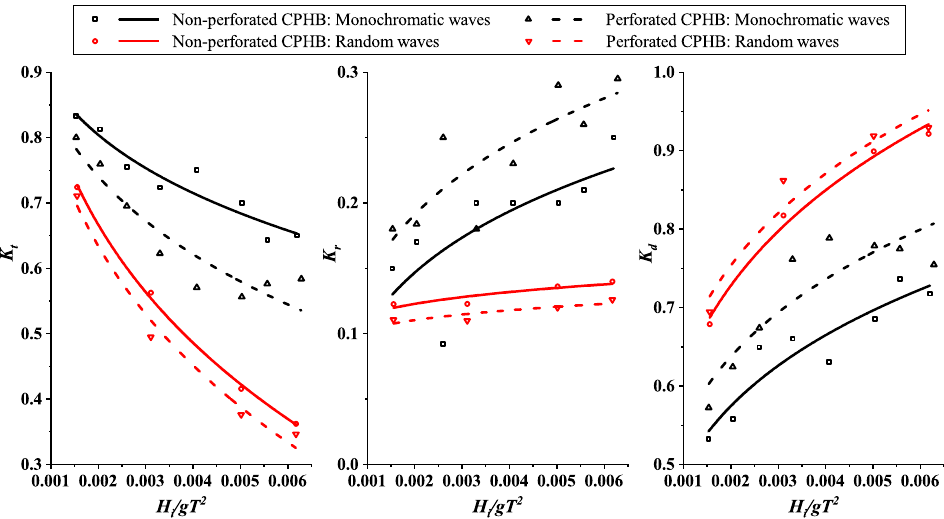
Figure 17. Comparison of performance characteristics between monochromatic and irregular waves for non-perforated and perforated